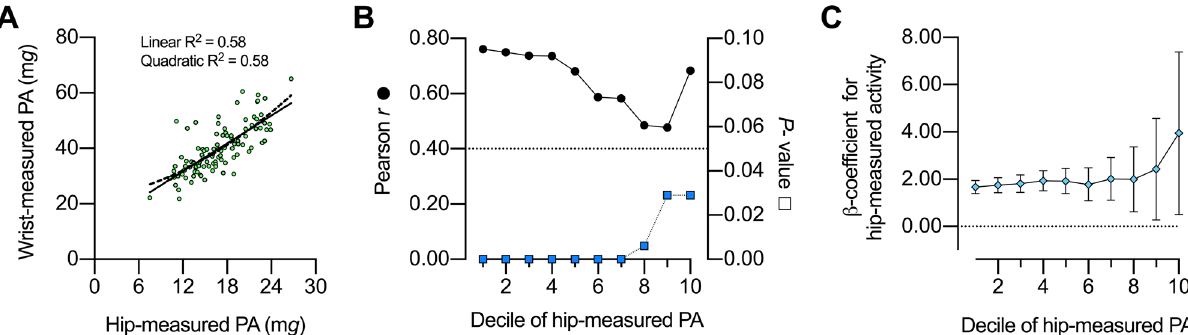
Figure 2. Association between wrist-measured and hip-measured physical activity [PA] in children. ( A ) Quadratic [dashed line] and linear [solid line] regression models. ( B ) Pearson r [circles] and P values [squares] for the associations between wrist-measured PA and hip-measured PA that include subjects from different deciles of hip-measured PA until the 10th decile; e.g. values for decile 9th indicate a correlation that includes subjects from the 9th to the 10th deciles. ( C ) Unstandardized ß-coefficients and 95% confidence intervals for the linear regression between wrist-measured PA vs. hip-measured PA that include subjects spanning different deciles of hip-measured PA, as explained in B. n =